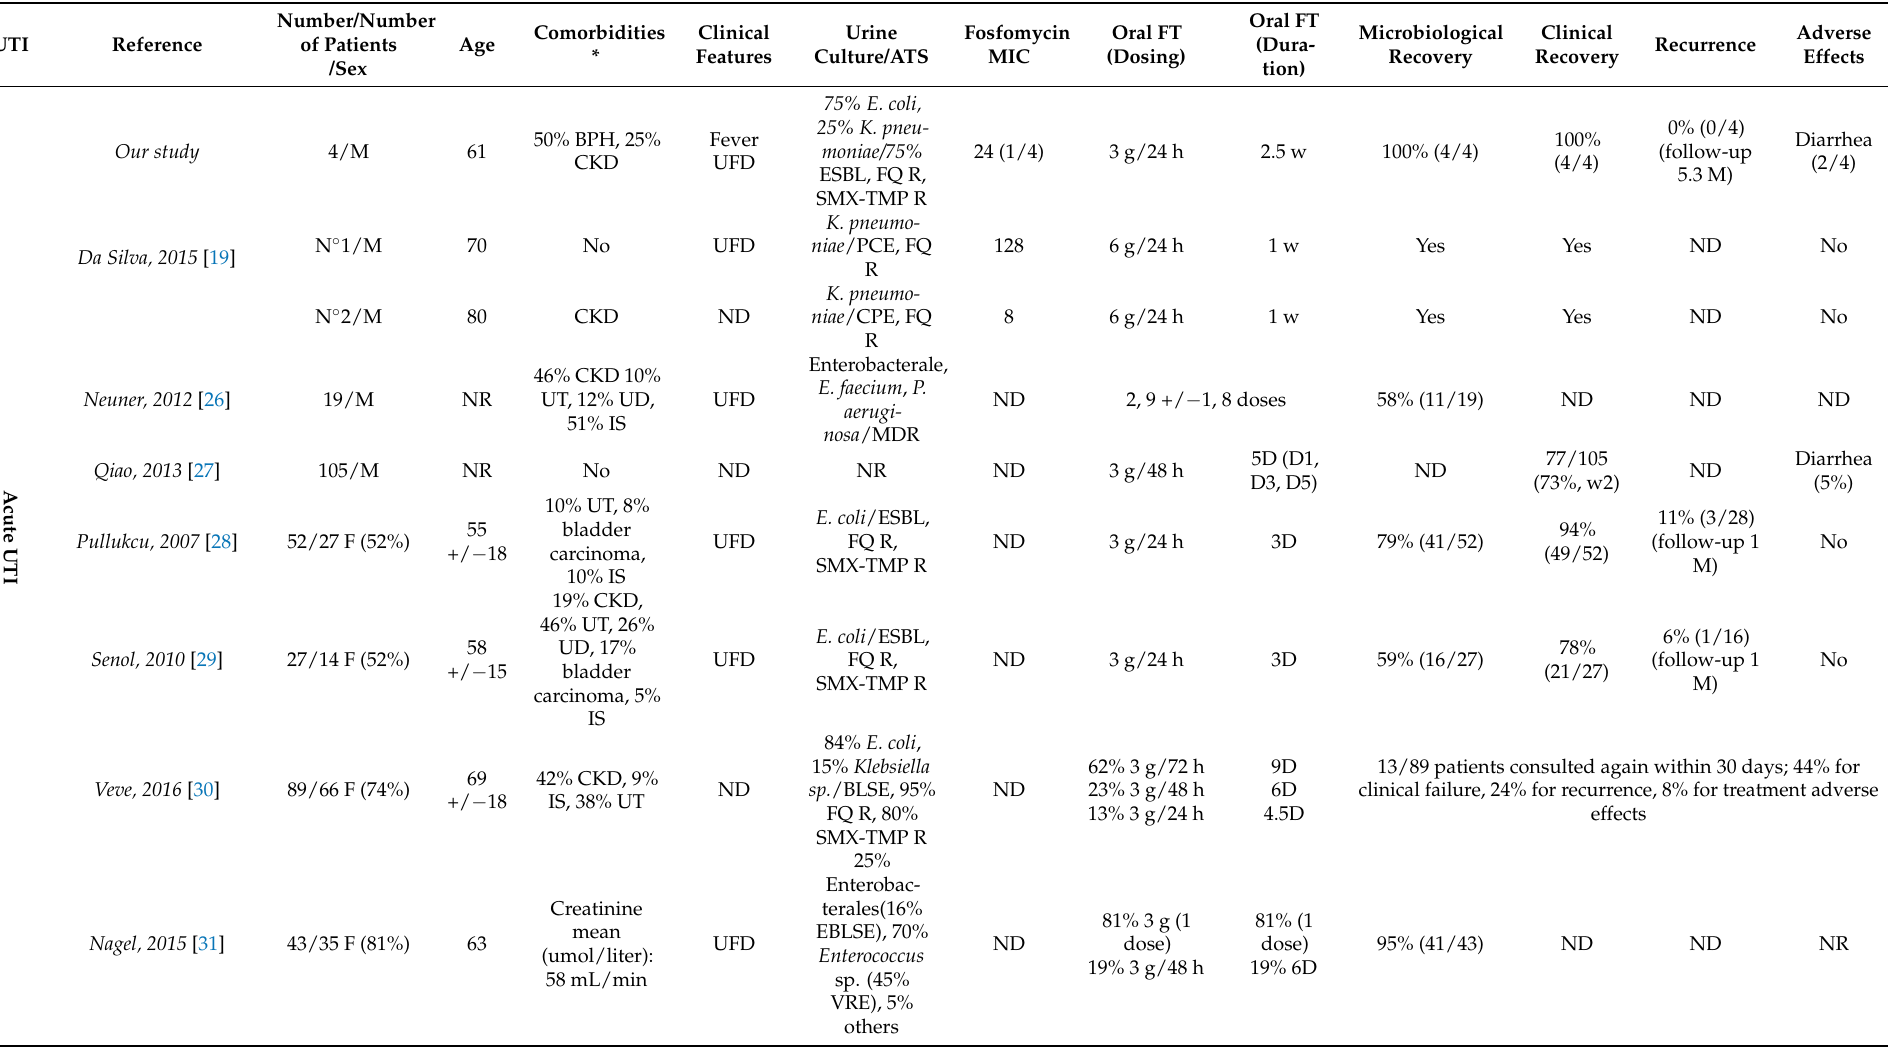
Table 2. Treatment of Male Urinary Tract Infection with Oral fosfomycin-trometamol (review of